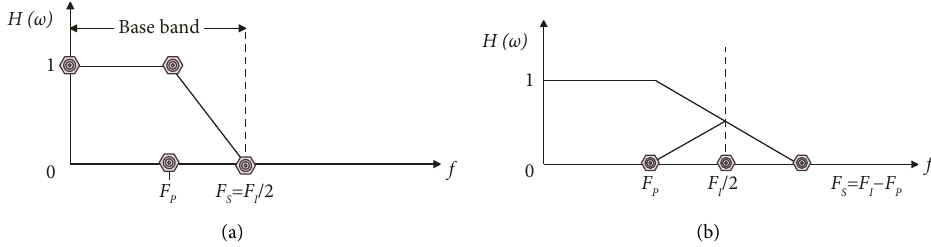
Figure 2: No aliasing and aliasing spectrum in transition band. (a) No aliasing in the transition. (b) Aliasing is allowed in the transition.